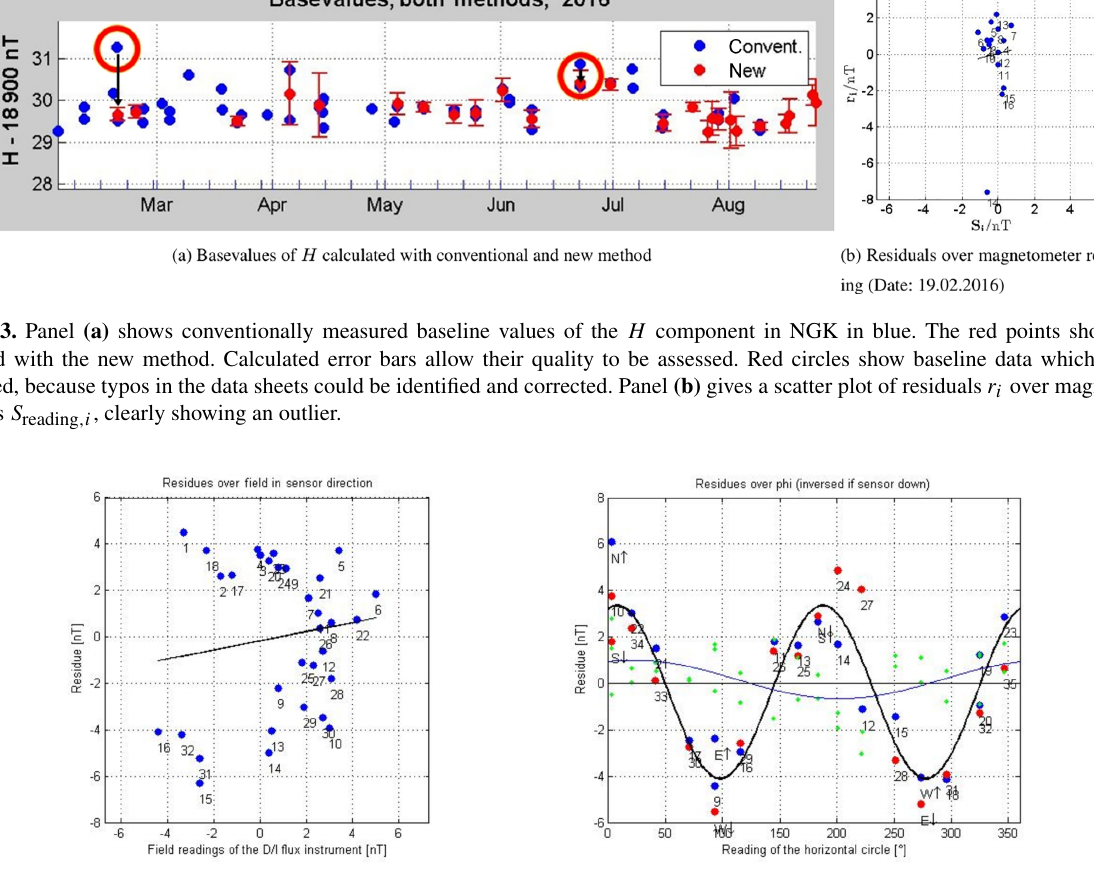
Figure 4. Panel (a) shows unsystematically increased residuals of a certain measurement. This indicates magnetic cleanliness problems with the operator. Panel (b) shows residuals which have a sinusoidal dependance of the pointing direction of the alidade ( ∼ sin ( 2 · ϕ + α) ). This indicates a systematic problem with the instrument. Measurements with the sensor above the telescope are coloured in blue; else they are in red. The green dots show the differences with respect to the fitted sin ( 2 · ϕ + α) curve. No sin (ϕ + α) dependency is